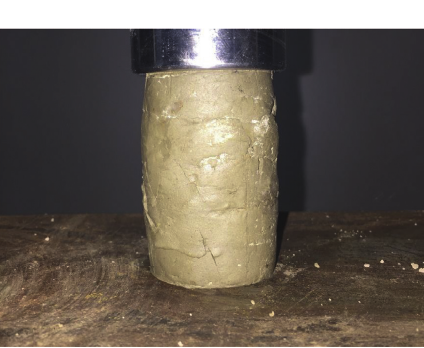
Figure 10: Photograph showing one of the 0.50mol/L soft clay specimens failing during an unconfined compression test.